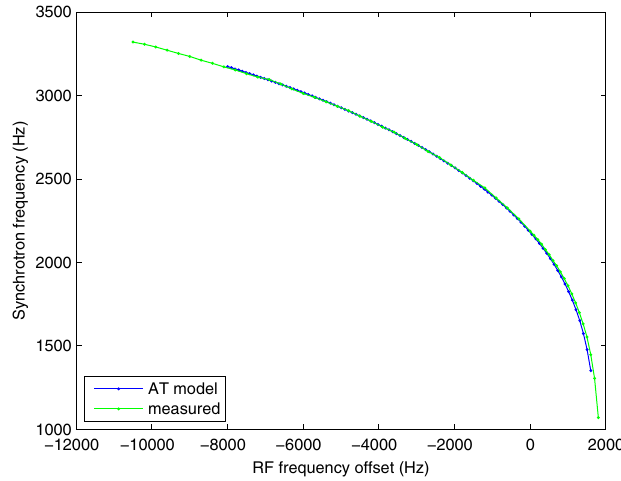
FIG. 6. Comparison of synchrotron frequency vs rf.